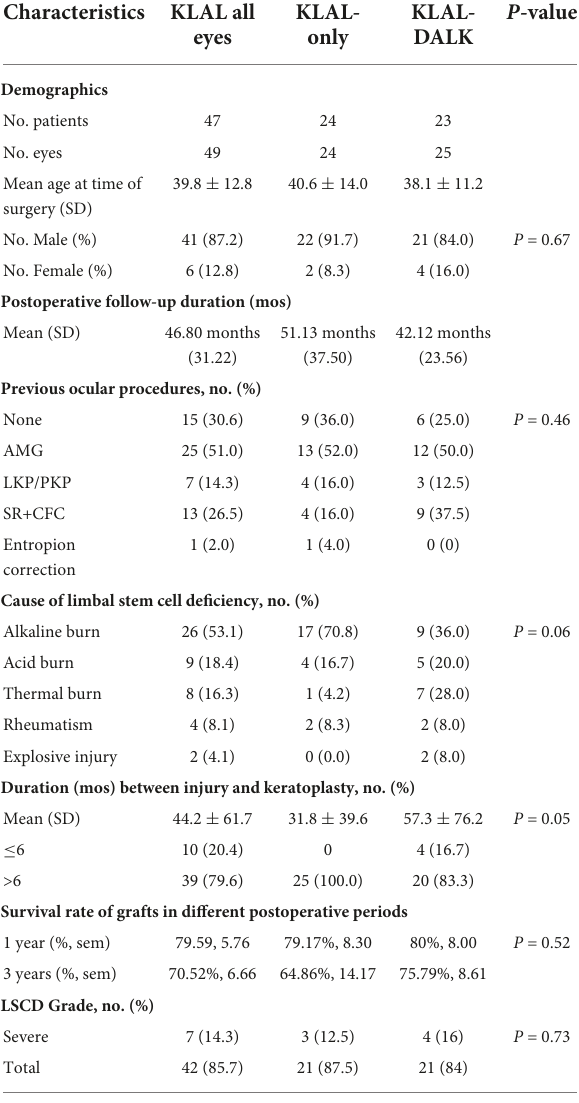
TABLE 1 Baseline characteristics of patients who underwent KLAL